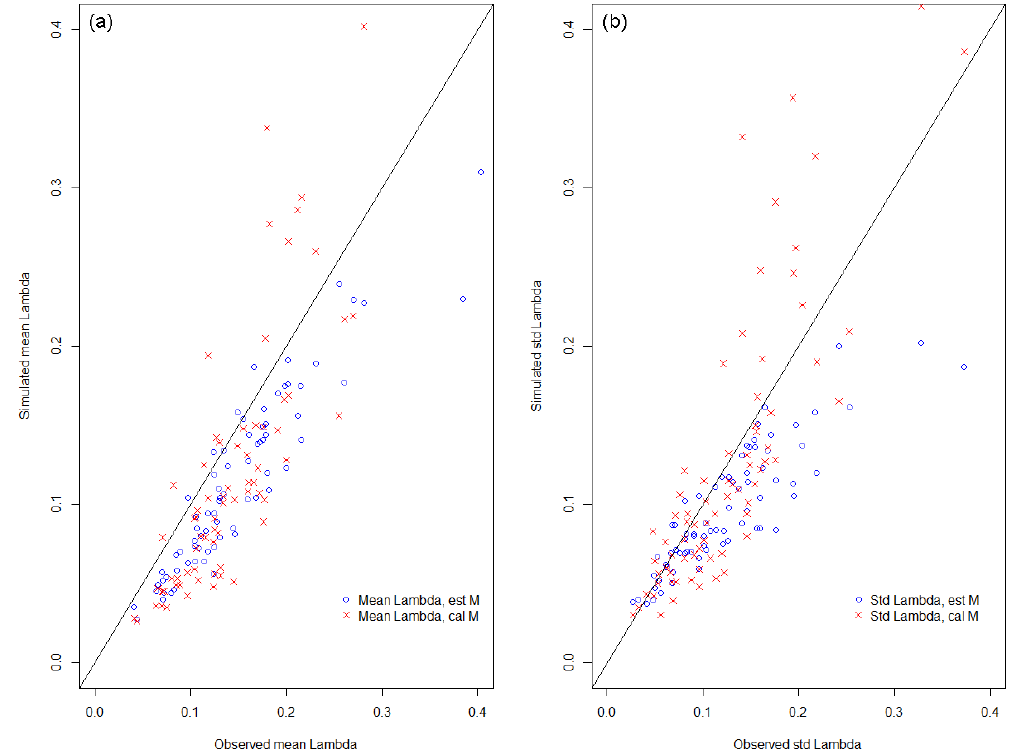
Figure 8. Scatterplot of mean (a) and standard deviation (b) of observed (cid:51) and simulated with DDD_ m S (blue circles) and DDD_ θ M (red crosses) ˙ (cid:51) for 73 catchments.